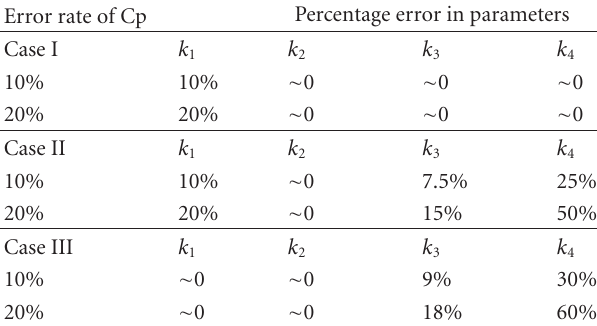
Table 2: The percentage error in estimated k 1 , k 2 , k 3 , and k 4 of tumor a ff ected by a range of erroneous blood functions in three